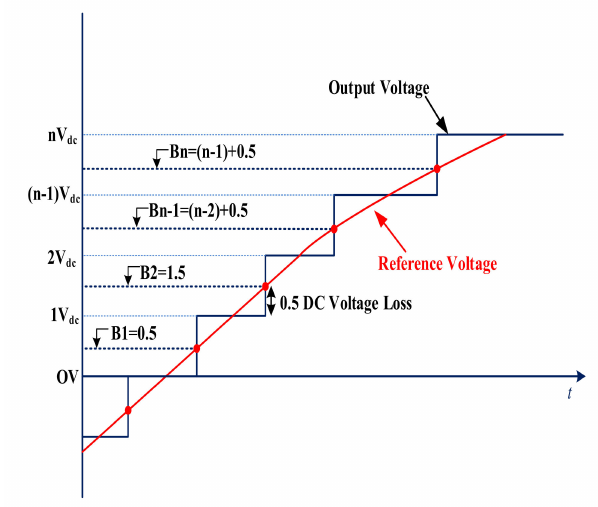
Figure 4. Level generation.